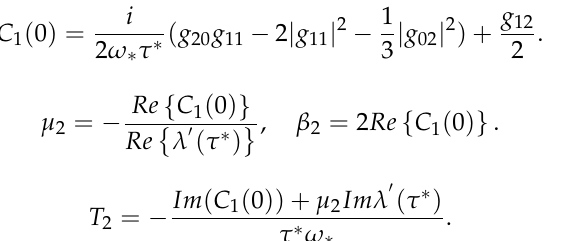
Figure 2. According the previous analysis, the equilibrium should be stable. The simulation results coincide exactly with the our